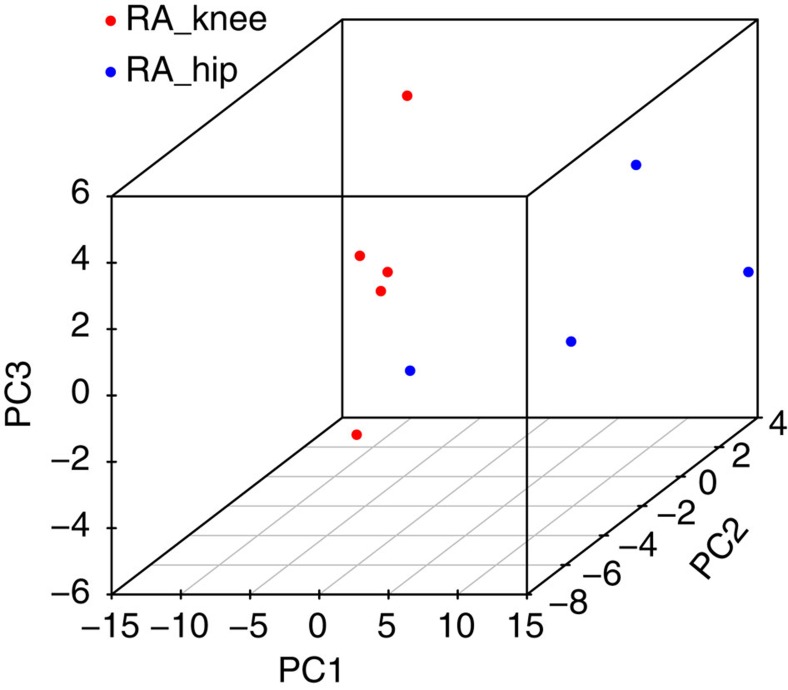
PCA of RA knee and RA hip FLS by differential gene expression analysis using RNA-seq.Distinct gene expression patterns were demonstrated that separated knee and hip transcriptomes. The PCA plot was generated using 107 DEGs between RA knee and hip FLS, with gene expression fold-change >2 and Benjamini–Hochberg adjusted P-values<0.05.